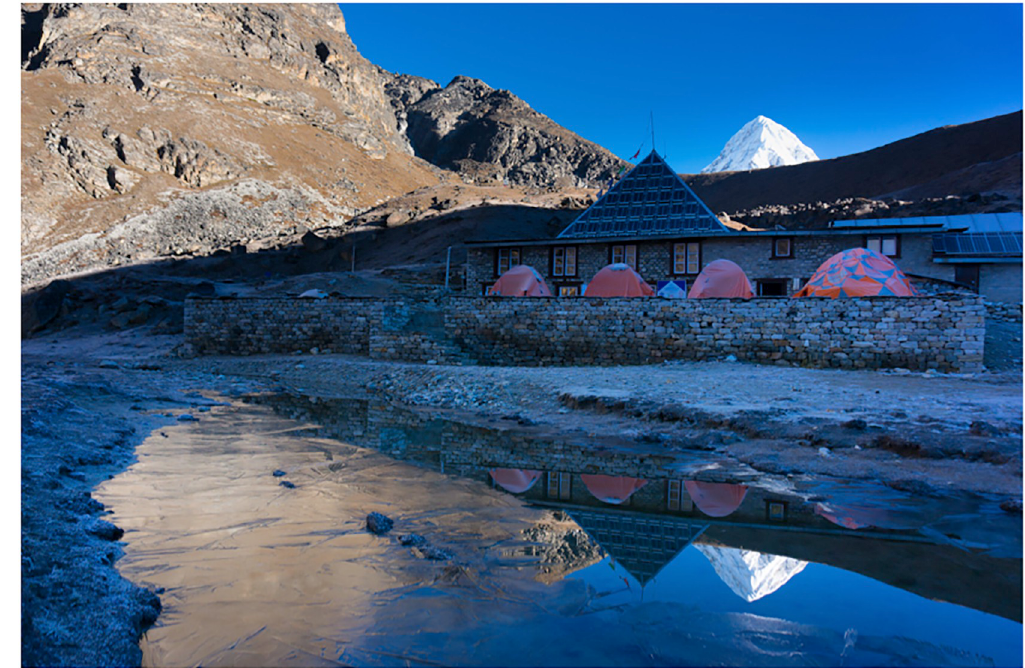
Fig 3. The Ev-K2-CNR laboratory, 5050m, Solokhumbu,